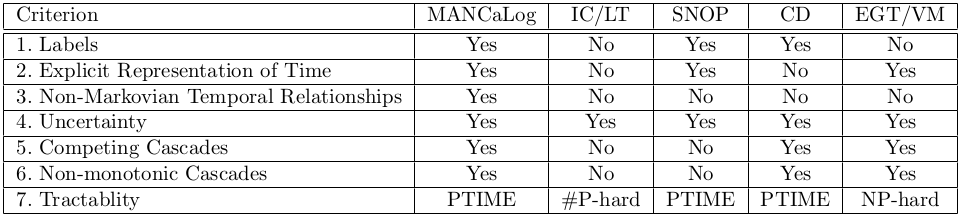
Table from the paper: MANCaLog: A Logic for Multi-Attribute Network Cascades (Technical Report)
Table text:
Criterion
MANCaLog
IC/LT
SNOP
CD
EGT/VM
1.Labels
Yes
No
Yes
Yes
No
2.ExplicitRepresentationofTime
Yes
No
Yes
No
Yes
3.Non-MarkovianTemporalRelationships
Yes
No
No
No
No
4.Uncertainty
Yes
Yes
Yes
Yes
Yes
5.CompetingCascades
Yes
No
No
Yes
Yes
6.Non-monotonicCascades
Yes
No
No
Yes
Yes
7.Tractablity
PTIME
#P-hard
PTIME
PTIME
NP-hard